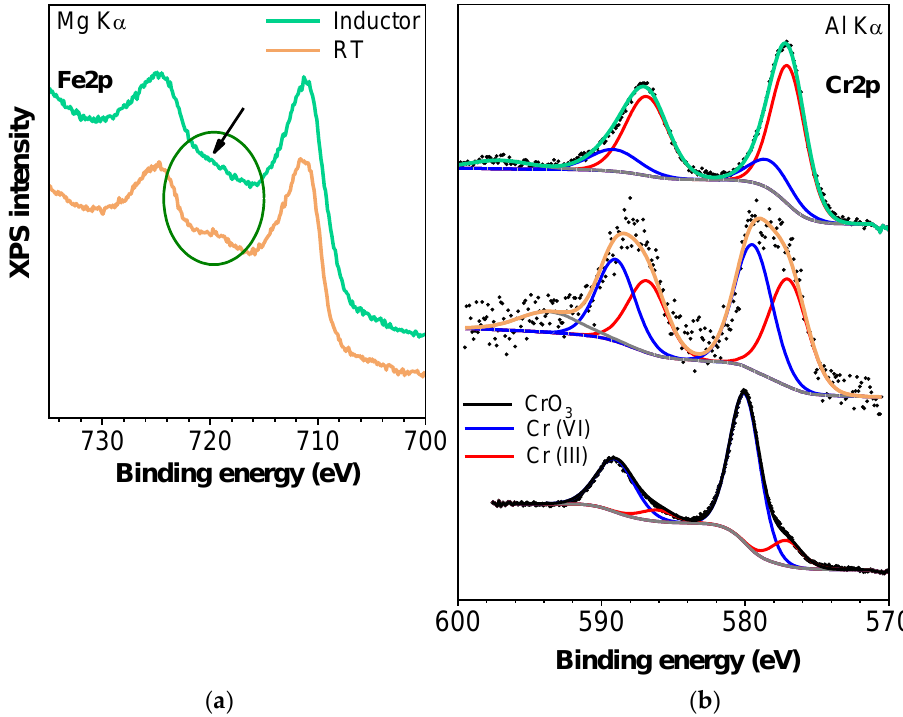
Figure 8. ( a ) Comparison of the normalized Fe2p X-ray photoelectron spectroscopy (XPS) spectra taken with Mg- Kα radiation corresponding to the absence and presence of magnetic inductor in the Cr adsorption experiments. ( b ) Normalized Cr2p XPS spectra taken with Al- Kα radiation from samples processed with / without inductor together with CrO 3 reference. Deconvolution of Cr2p spectra with fit composed of chemically shifted components associated to VI and III oxidation states. Data points in every spectrum are represented as black symbols, and Shirley background and component peaks using solid lines.